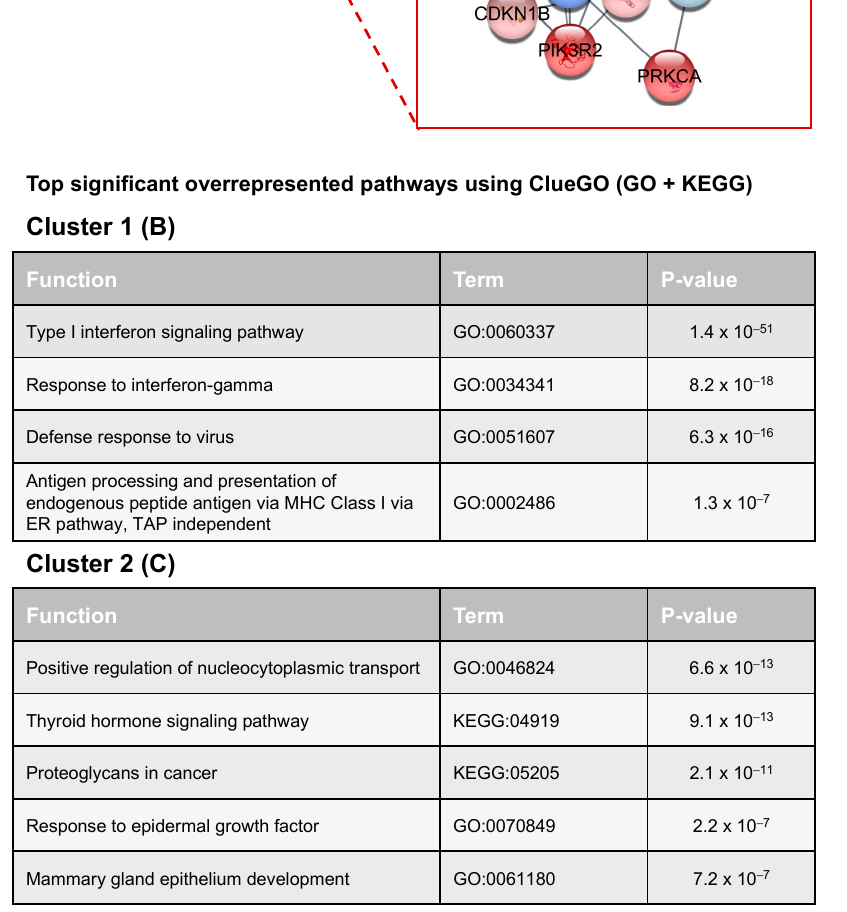
Figure 5. Critical signaling pathway analysis: ( A ) Protein–protein interaction network of DEGs